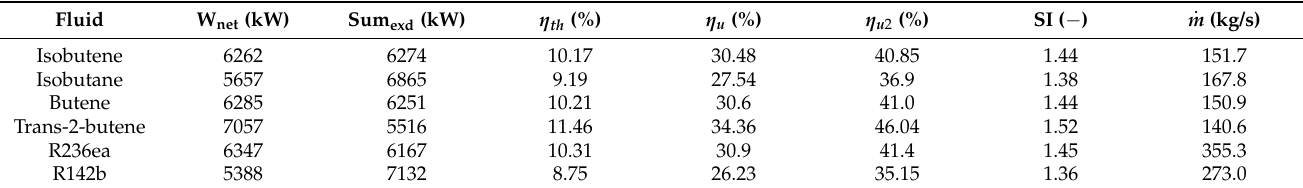
Table 5. Optimized model for different working fluids for 10 ◦ C pinch point for the regenerative ORC model. Fluid Isobutene